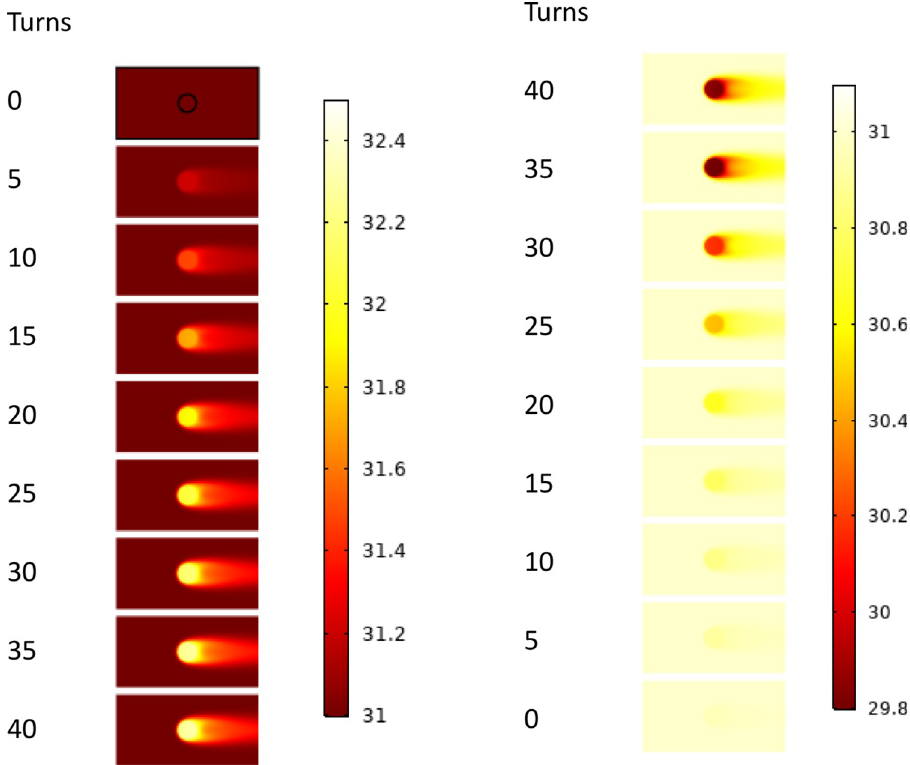
Fig 17. Simulated temperature distribution of the nitinol wires in a nitinol wire-stepping motor unit at various torsion turns ( n = 1